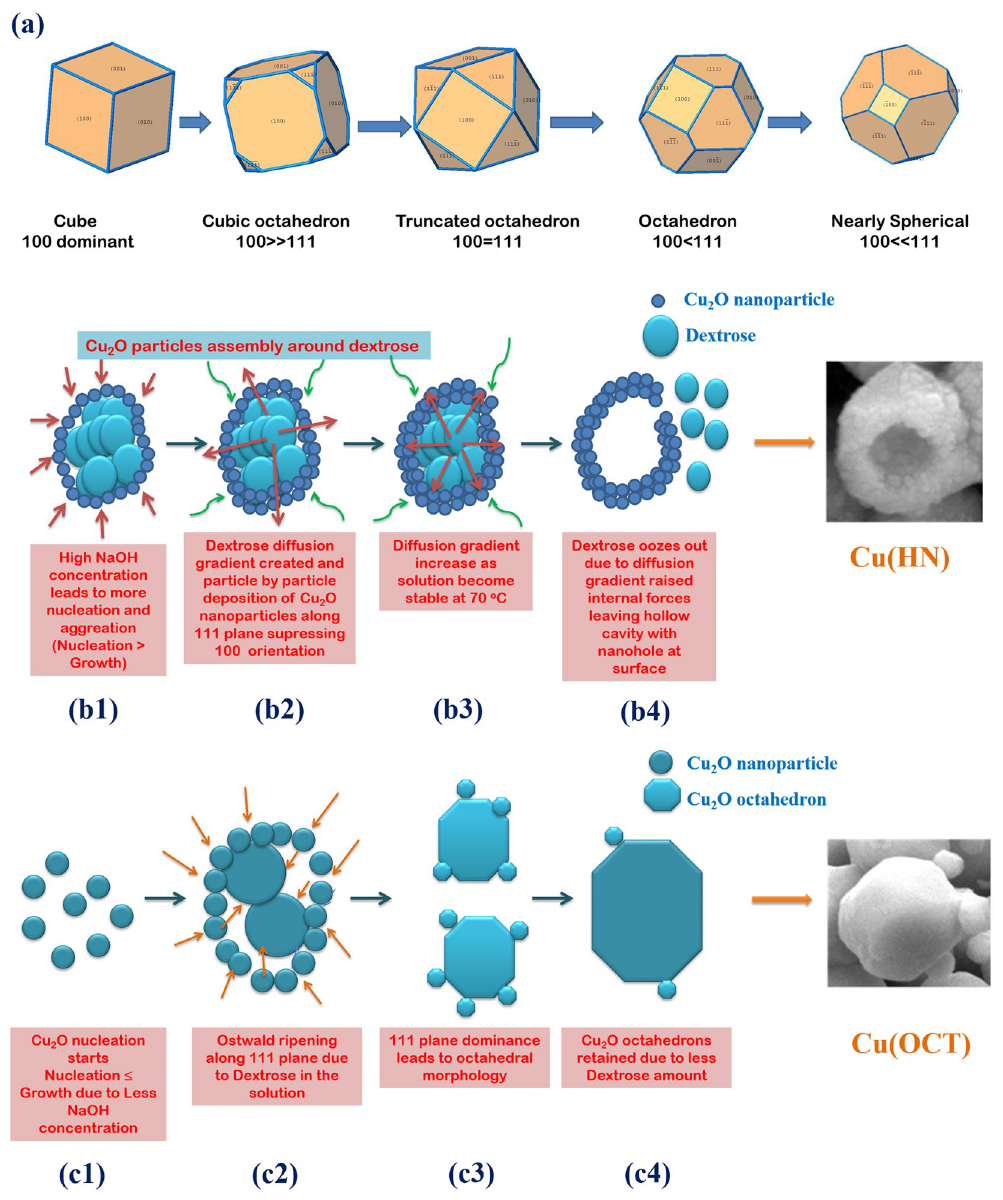
Figure 2. ( a ) Artificial crystal morphologies of Cu 2 O crystal explaining growth of Cu(HN) and Cu(OCT), (b1- b4) Growth mechanism Cu(HN) and (c1-c4)